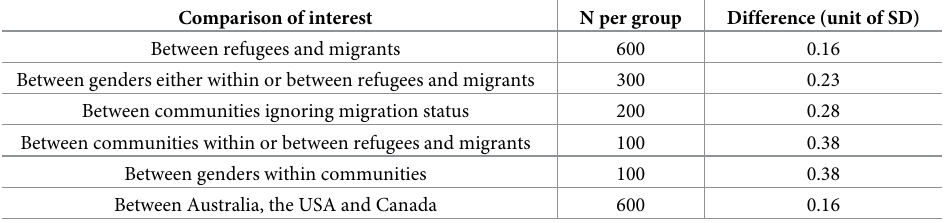
Table 1. Approximate differences (SD units) detectable with a 2-sided significance of 5% and power of 80% (given normally distributed measures), for selected comparisons of interest, based on an independent sample